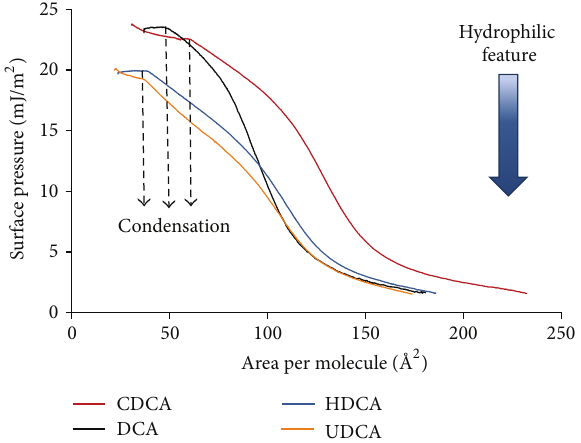
Figure 4: Compression isotherms of CDCA, DCA, HDCA, and UDCA measured on 3M NaCl at pH = 1.2 aqueous subphase at 25 ± 0.1 ∘ C. Increasing hydrophilicity of molecules is indicated by the arrow. Surface pressure unit is expressed in mJ/m 2 instead of the commonly applied mN/m.